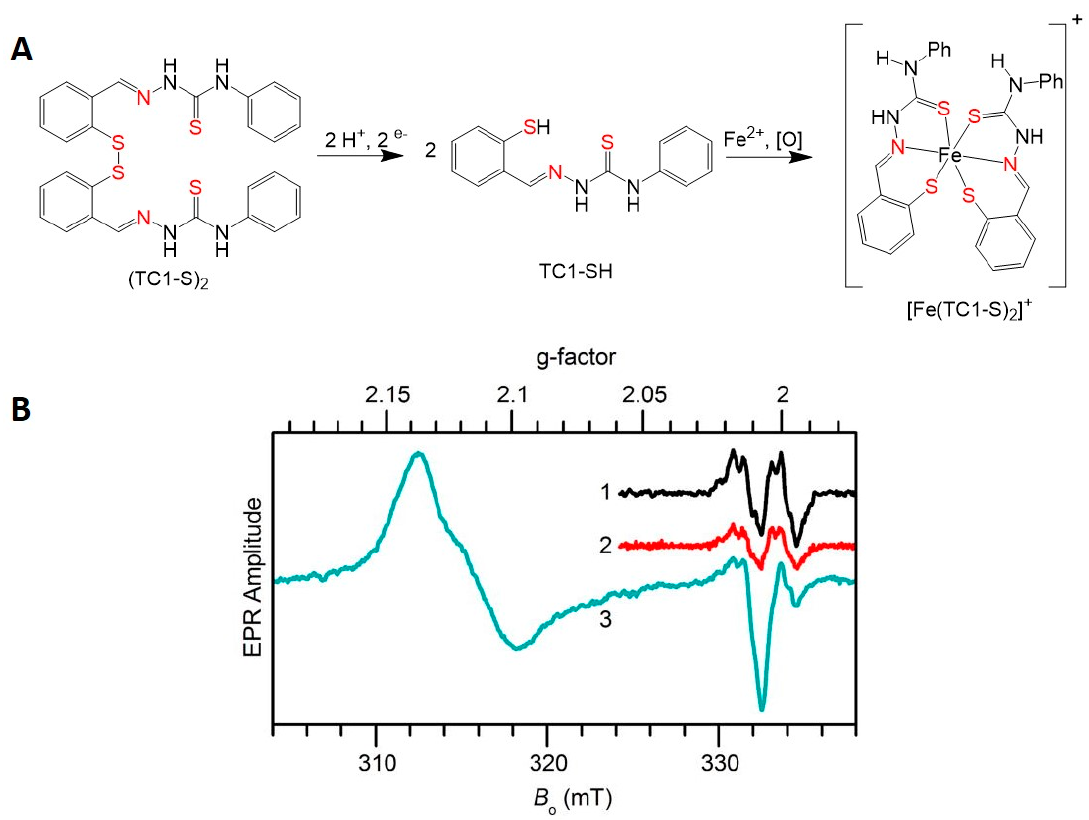
Figure 10. ( A ) Schematic of the reduction of the prochelator (thiosemicarbazones (TSC)-S) 2 for the activation of an antiproliferative thiosemicarbazone chelator (TC1-SH). This chelator would bind Fe from the LIP. ( B ) Enhanced permeation and retention (EPR) spectra of whole Jurkat cells: (1) untreated cells, (2) after treatment with 50 µ M DFO for 3 h, and (3) after treatment with 50 µ M (TC1-S) 2 for 1 h. Experimental conditions: microwave frequency, 9.338 GHz; microwave power, 2 mW; magnetic field modulation amplitude, 0.5 mT; temperature, 30 K. Reprinted with permission from Metallomics , 6, 1905–1912. Copyright 2014 Royal Society of Chemistry [187].